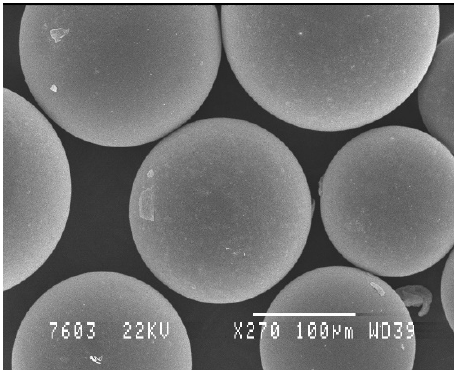
Figure 3. SEM micrographies of PLA microparticles prepared by oil-in-water emulsion process where growth factors can be loaded either as a solid dispersion in the oil, either adopting a double emulsion (W/O/W) evaporation procedure. SEM image of the microparticles was made by authors. This approach was already suggested several years ago by Perez et al. [126] or J.P.